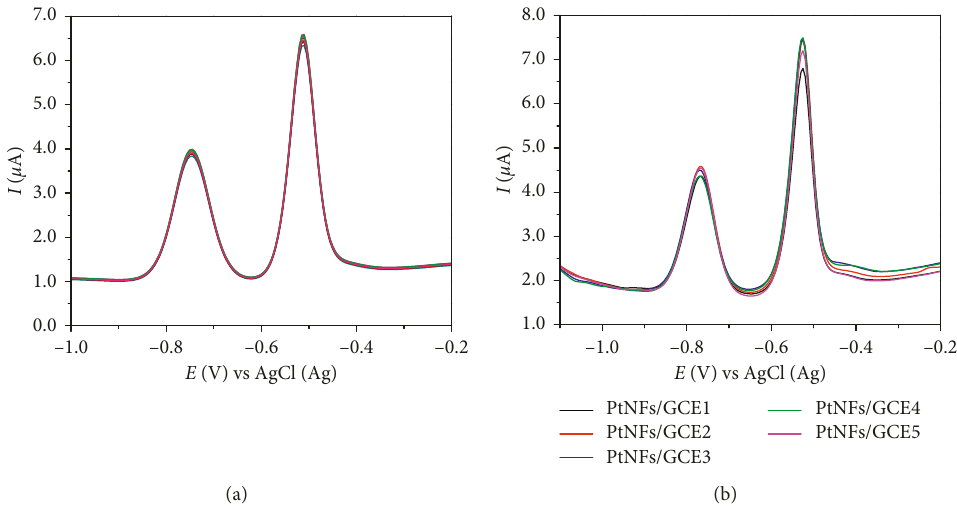
Figure 8: The DPASVs of 10 µ g · L − 1 · Pb 2+ and Cd 2+ in acetate buffer (pH 4.5) at one PtNFs/GCE with ten successive measurements (a) and at five different electrodes